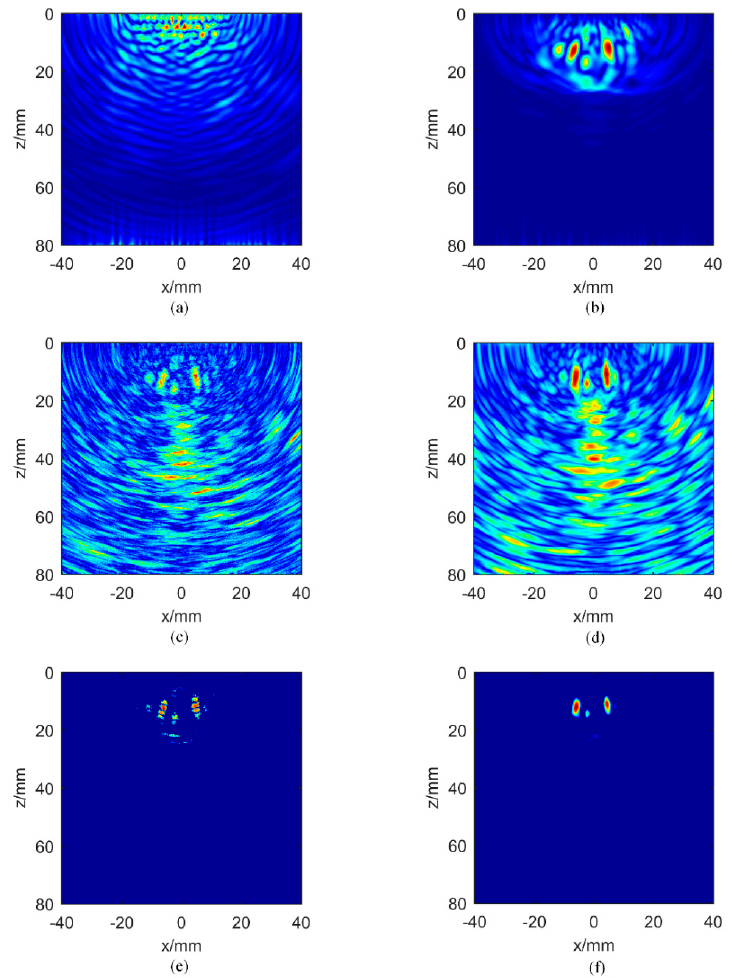
Figure 5. Images of aluminum plate A: amplitude total focusing method (TFM) images for ( a ) the direct full matrix and ( b ) the hybrid full matrix; instantaneous phased coherence weighting factor for ( c ) instantaneous phase weighting factor (IPWF) and ( d ) instantaneous phase coherence factor (IPCF), σ = 1; amplitude images multiplied by ( e ) IPWF and ( f ) IPCF, σ =